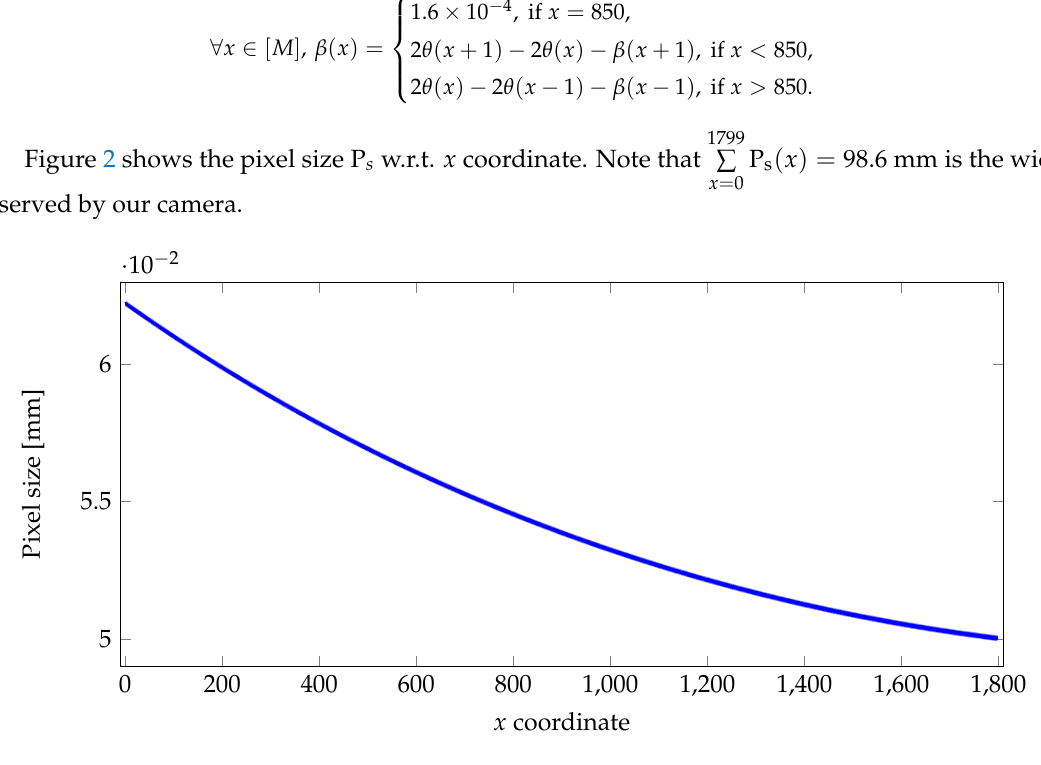
Figure 2. Size of surface element P s ( x ) (in mm) observed by each pixel of coordinate x . The